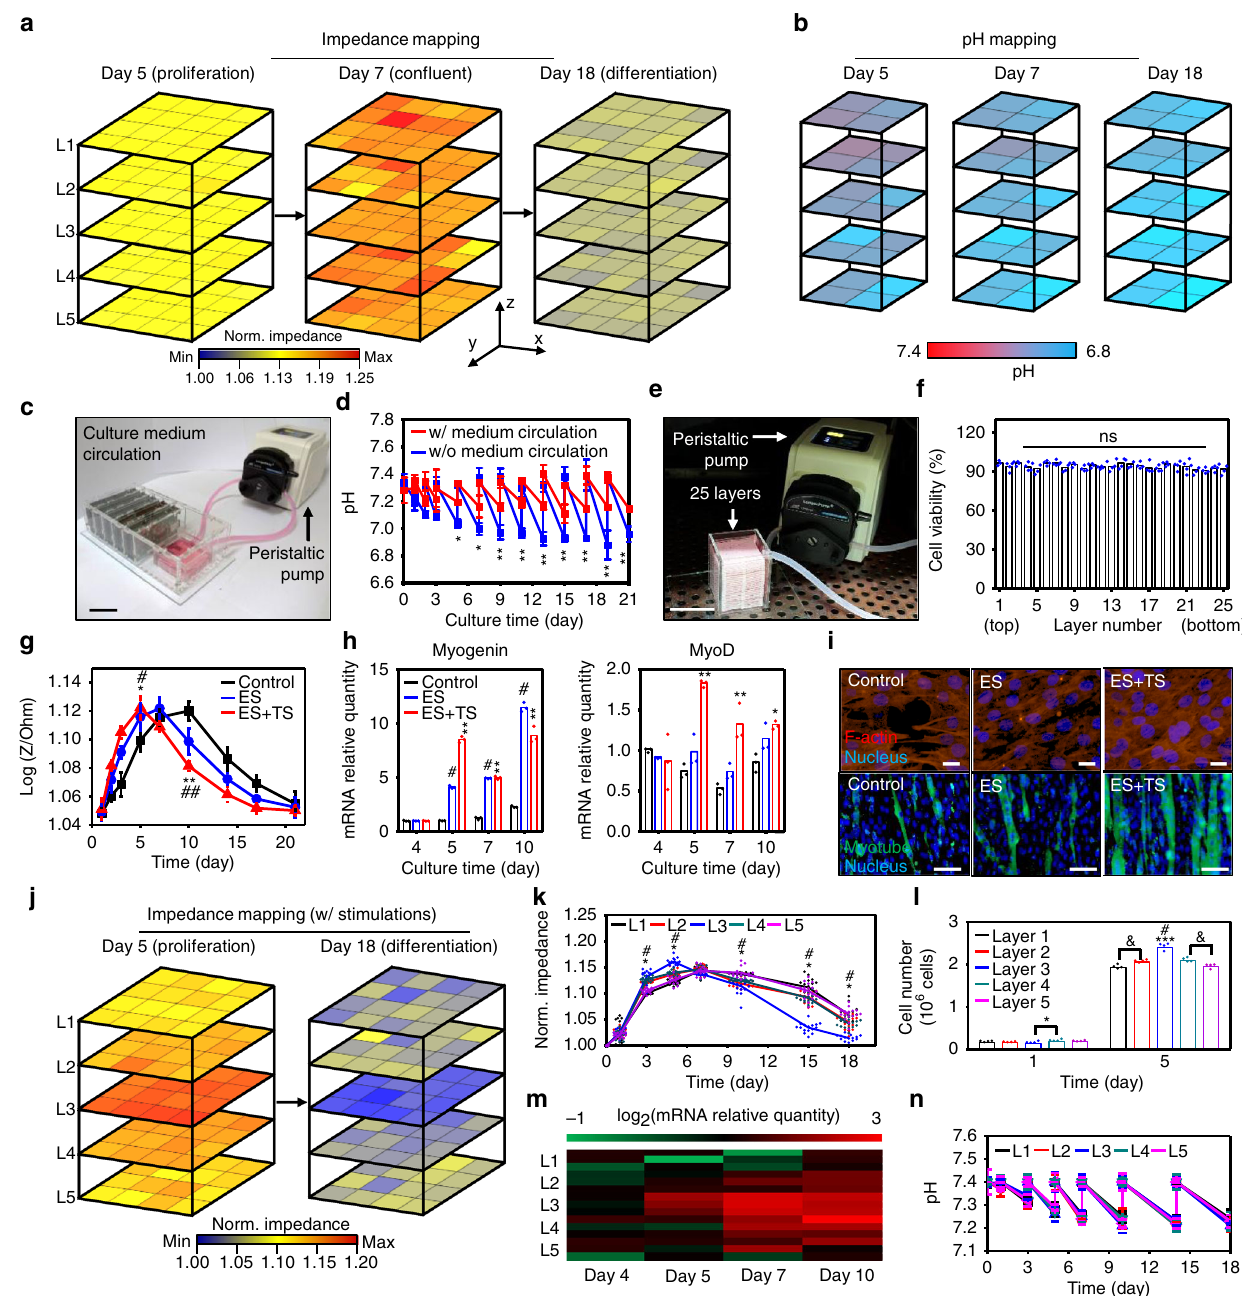
Fig. 5 3D array monitoring and stimulation control of C2C12 culture with LISCCP. a Impedance mapping of C2C12 cells cultured on the fi ve-layered LISCCP without stimulations. Con fl uence appears at day 7 (red) before the differentiation proceeds. b Corresponding 3D pH mapping to a . c Photograph of LISCCP integrated with a peristaltic pump for culture medium circulation. Scale bar: 5 cm. d Pro fi les of pH with and without circulation of culture medium ( n = 4, mean ± s.d., * P < 0.01, ** P < 0.001, ANOVA). e Photograph of 25 culture layers with a culture medium circulation unit. Scale bar: 5 cm. f Cell viability at each layer in the 25-layer LISCCP ( n = 5, ns, no signi fi cant; ANOVA). g Impedance monitoring for C2C12 cells cultured under ES, TS, or ES + TS. No stimulation was applied for the control ( n = 4, mean ± s.d., ES + TS compared to control, * P < 0.01, ** P < 0.001; ES compared to control, # P < 0.01, ## P < 0.001, ANOVA). h Expression of the muscle gene markers, myogenin (left) and MyoD (right), during the differentiation period ( n = 3, mean ± s.d., ES + TS compared to control, * P < 0.01, ** P < 0.001; ES compared to control, # P < 0.001, ANOVA with Bonferroni ’ s post-test). i Fluorescent analysis of C2C12 cells cultured without (control) and with stimulations (ES, TS, ES + TS). F-actin is stained red on day 5, myotube in green on day 10, and nucleus in blue. Scale bars for F-actin: 10 μ m and for myotube: 50 μ m. j Impedance mapping of a fi ve-layered LISCCP when ES and TS are applied only on the third layer. k Impedance pro fi les of C2C12 culture on fi ve layers with ES and TS (* P < 0.001, L3 compared to L1; # P < 0.001, L2 compared to L1). l Cell growth pro fi les showing increased cell growth on the stimulated layer ( n = 4, * P < 0.05; *** P < 0.001 versus layer 1 and layer 5; # P < 0.001 versus layer 2 and layer 4, & P < 0.05, ANOVA). m Myogenic gene expression in C2C12 during differentiation ( n = 3). n Pro fi les of pH on fi ve layers ( n = 4, mean ±